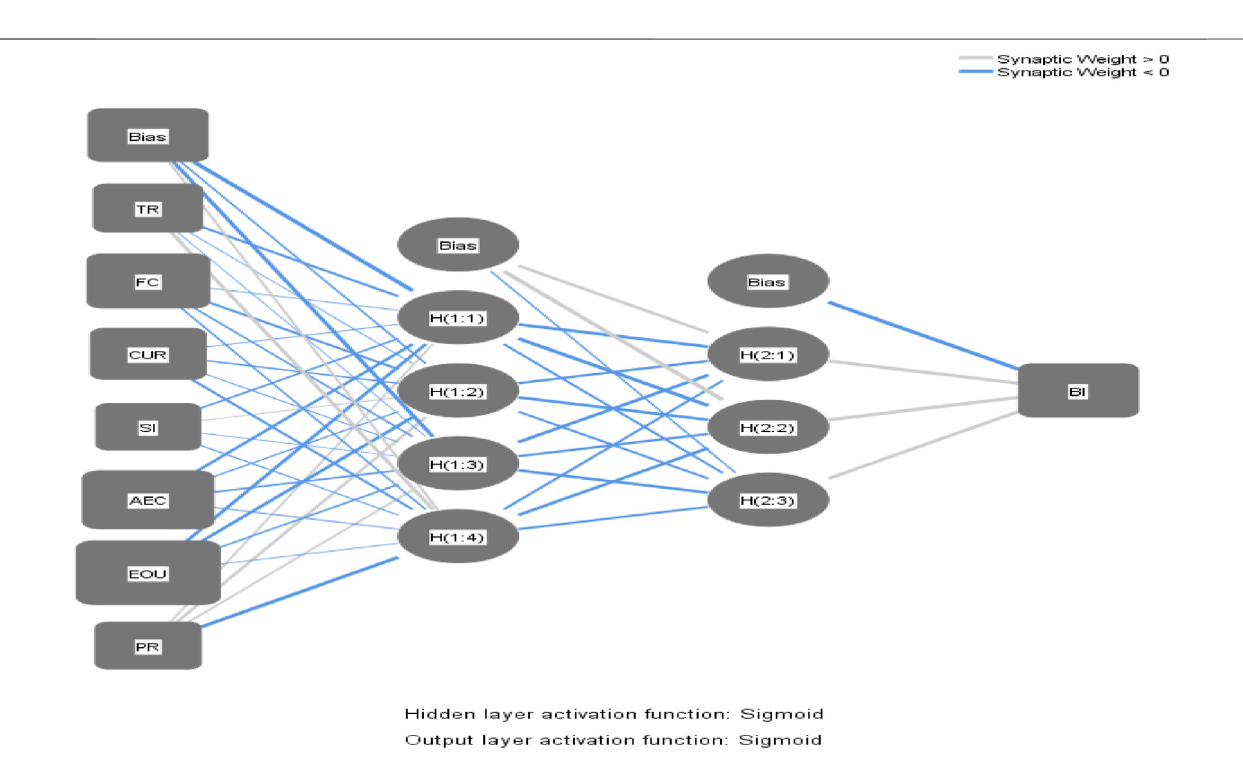
FIGURE 4 | ANN model for